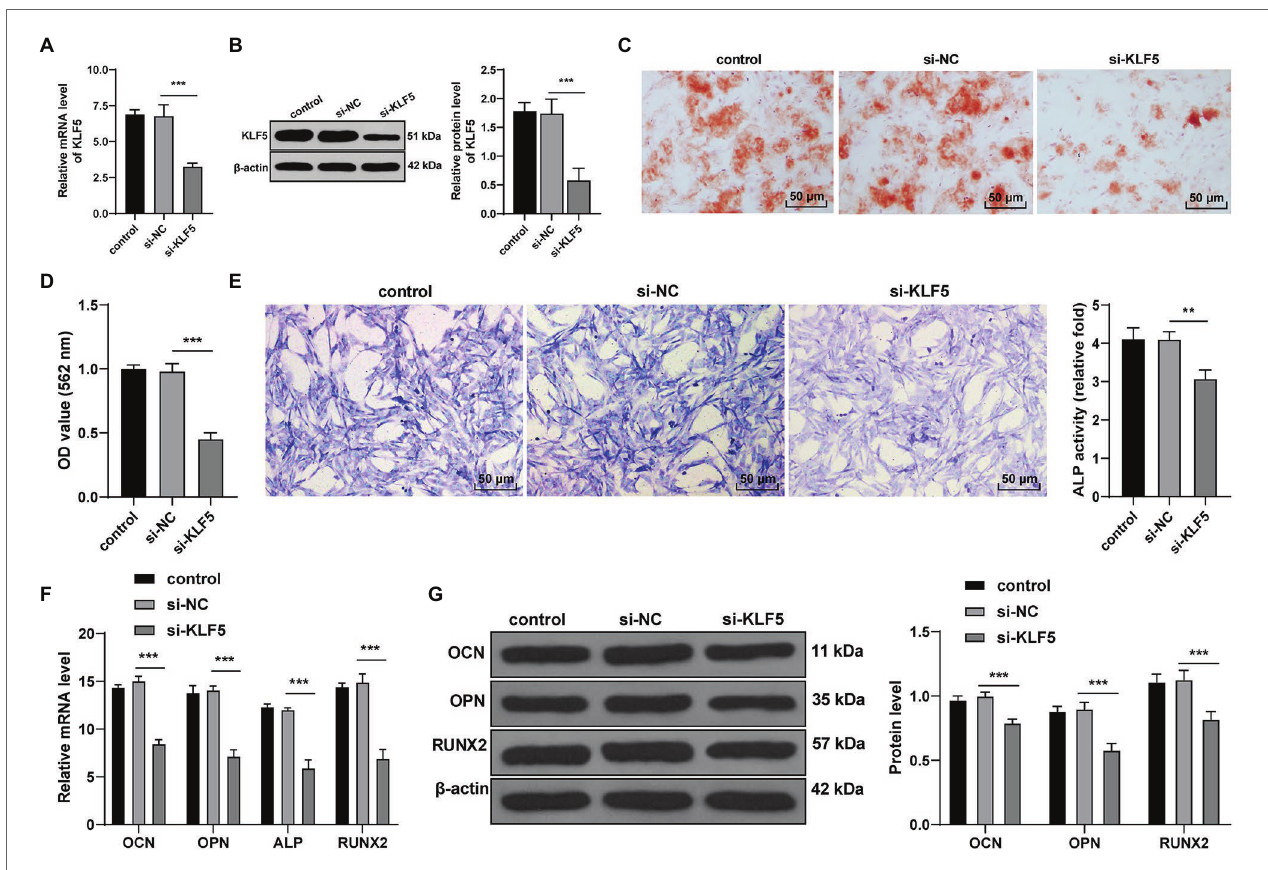
FIGURE 2 | KLF5 silencing inhibited the osteogenic differentiation of hPDLCs. (A,B) Silencing effect of siRNA on KLF5 was measured using RT-qPCR and Western blotting. (C,D) Effect of KLF5 on osteogenic differentiation of hPDLCs was measured using ARS staining and ARS semi-quantitative analysis. (E) ALP activity was measured using ALP staining. (F,G) Changes of OCN, OPN, ALP, and Runx2 in hPDLCs were measured using RT-qPCR and Western blotting. Data are expressed as mean ± standard deviation. One-way ANOVA was applied to assess data in panels (A,B,D,E) , and two-way ANOVA was applied to assess data in panels (F,G) , followed by Dunnett’s multiple comparisons test or Tukey’s multiple comparisons test, ** p < 0.01, *** p <